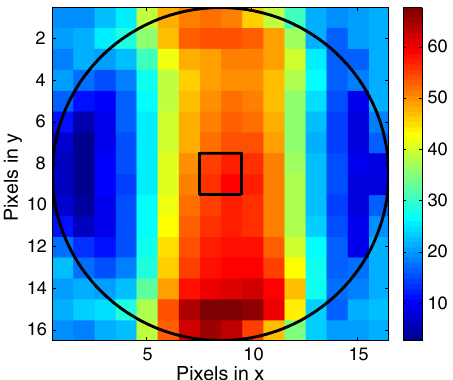
FIG. 8. Reconstructed dose map for the 2 (cid:1) 2 cm 2 in the cylindrical phantom. The legend on the right represents the dose value in cGy.